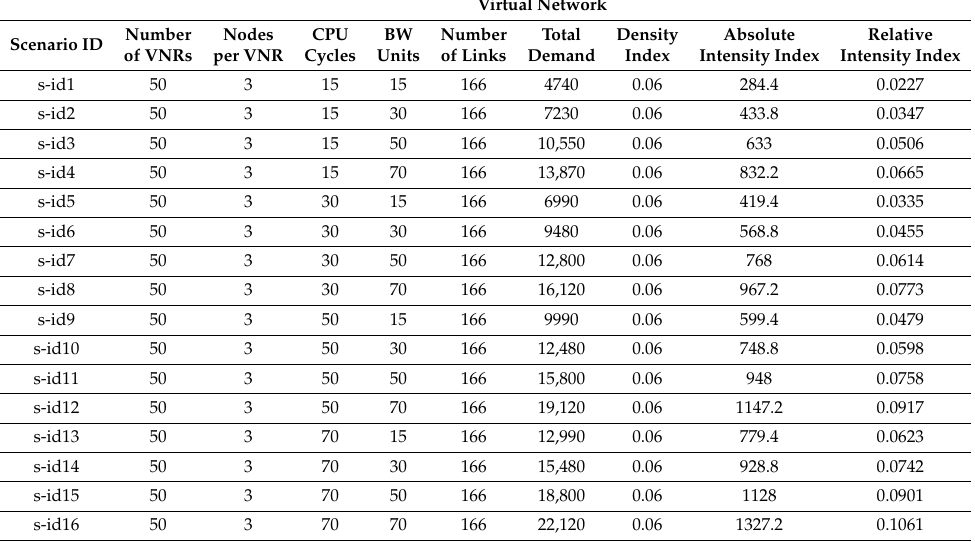
Table 6. RII of R-ViNE-PS in the many–small parameter